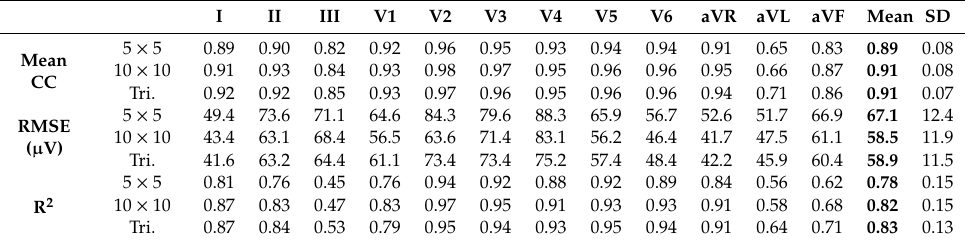
Table 4. CC, RMSE and R-square values of each 12-lead ECG for the meanCC approach with the ANN model.